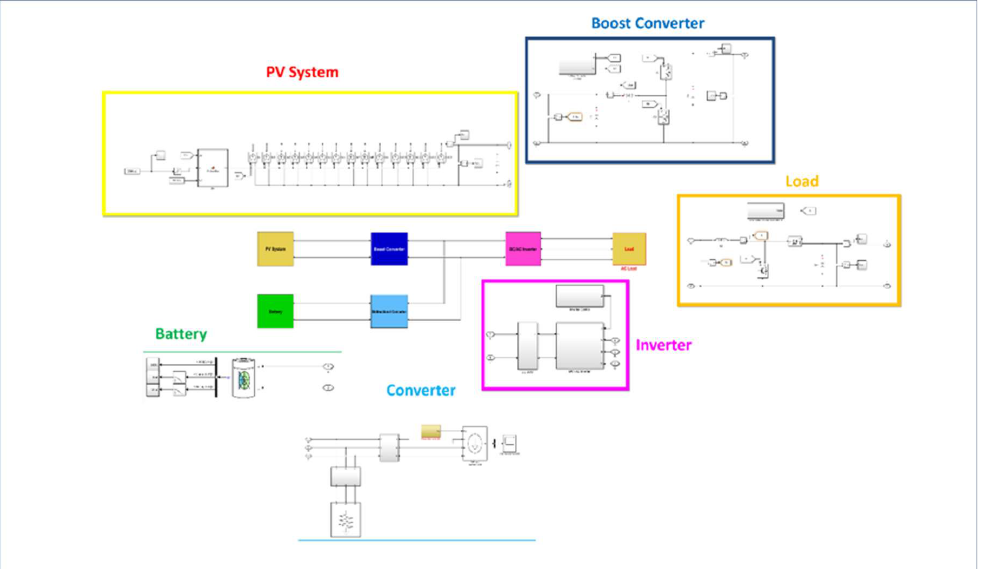
Figure 9. Simulink model of microgrid.